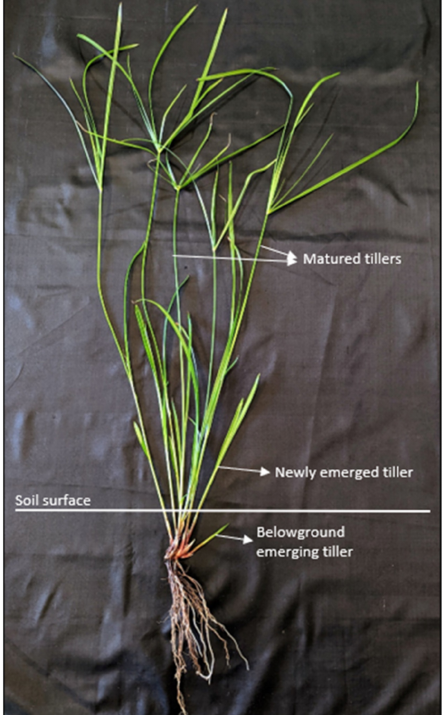
Figure 4. Classification of underground emerging tillers, newly emerged tillers. and matured tillers of Cyperus aromaticus